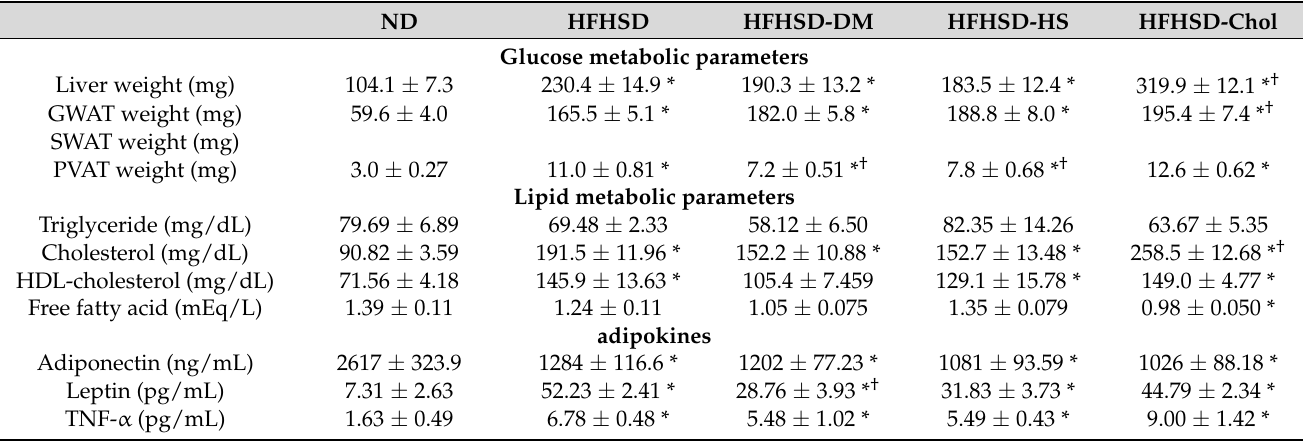
Fasting glucose with n = 8 per group, fasting insulin with n = 10–14 per group, Triglyceride, cholesterol, HDL- cholesterol, free fatty acid with n = 12–16 per group, Adiponectin with n = 8 per group, Leptin with n = 7–8 per group, TNF- α with n = 9–10 per group. Data are presented as mean ± SE. * p < 0.05 compared to ND and † p < 0.05 compared to HFHSD. ND indicates normal diet group; HFHSD, high-fat/high-sucrose (HFHSD) diet group; HFHSD-DM, HFHSD group, which were received streptozocin (STZ) (50 mg/kg/day for 2 days on the age of 20 weeks); HFHSD-HS, choline deficient HFHSD group; HFHSD-Chol, 1% cholesterol and 0.1% deoxycholic